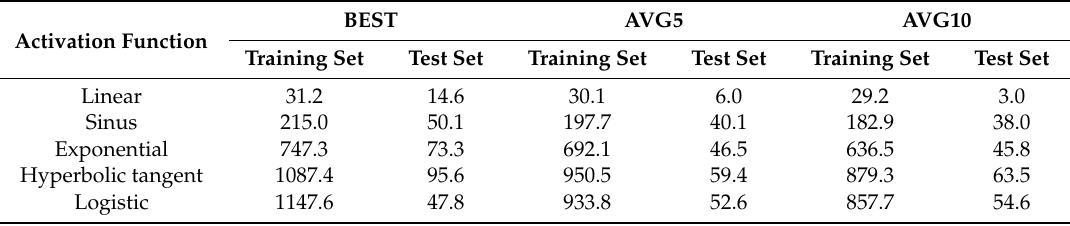
Table 5. Results (in USD / b) obtained in the SANN including the activation function used in the hidden layer.